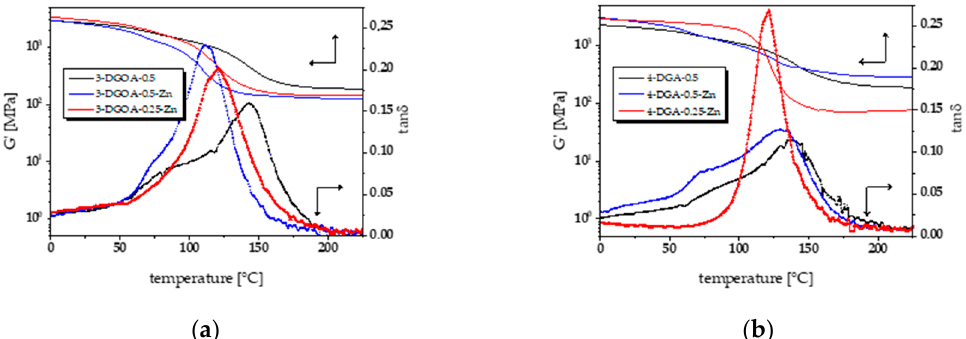
Figure 3. Storage modulus ( G ’) and tan δ curves of epoxy-anhydride vitrimers from ( a ) 3-DGOA and ( b ) 4-DGA.